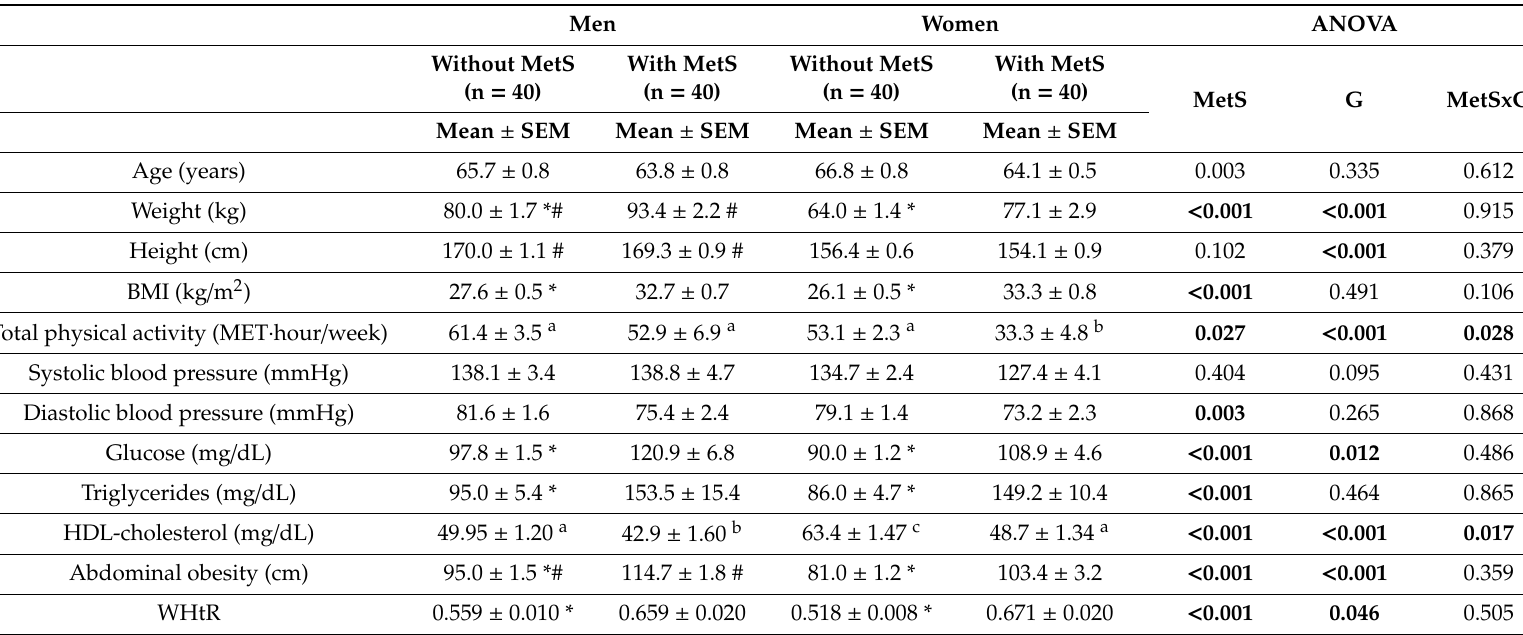
Table 1. Characteristics of participants “without Metabolic Syndrome” (n = 80) and “with Metabolic Syndrome” (n = 80) stratified by gender.